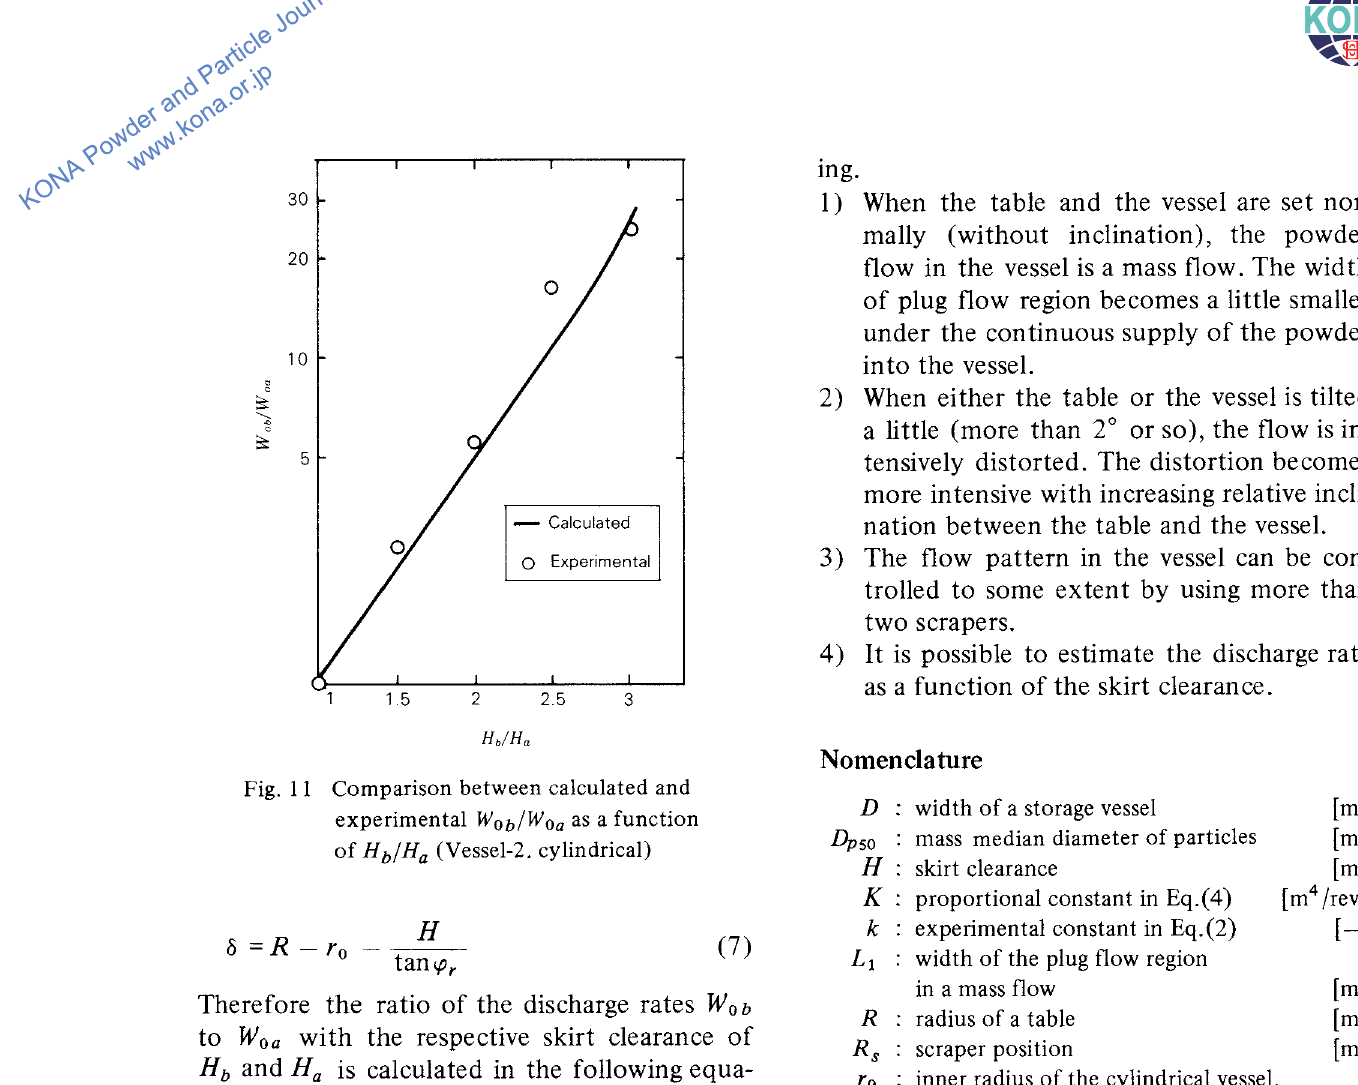
Fig. 11 Comparison between calculated and experimental Wob!Woa as a function of Hb/Ha (Vessel-2.